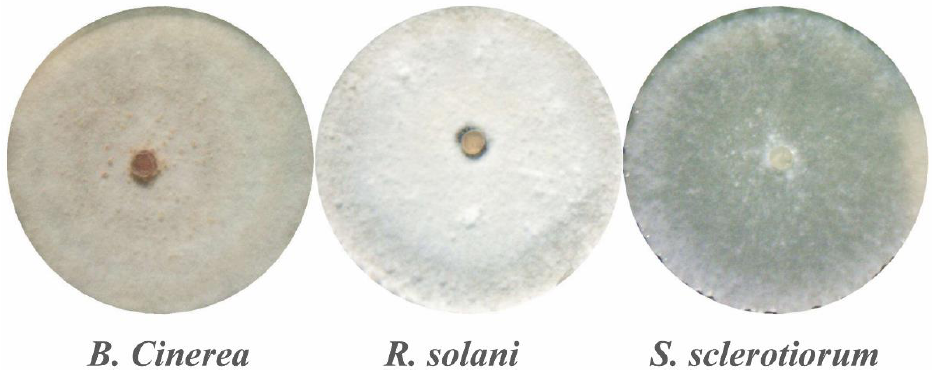
Figure 1. Three species of fungal cultures on Petri dishes.